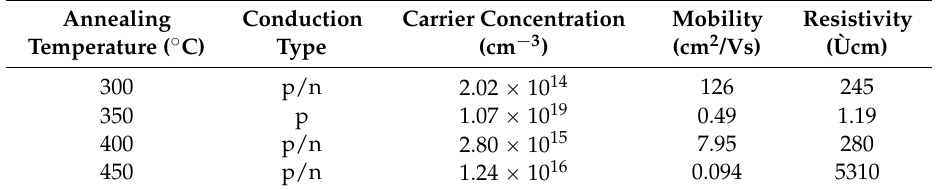
Table 2. Temperature dependence of conduction type, carrier concentration, mobility, and resistivity of the CZTS thin film measured using Hall measurements.